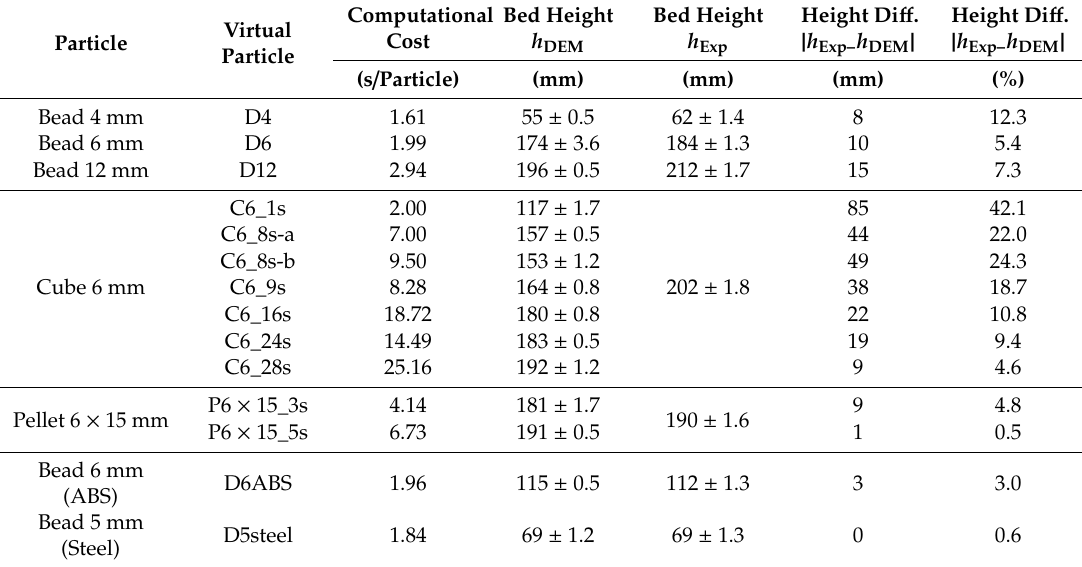
Table 7. Comparison of the packing test’s experimental and simulation results before optimization.